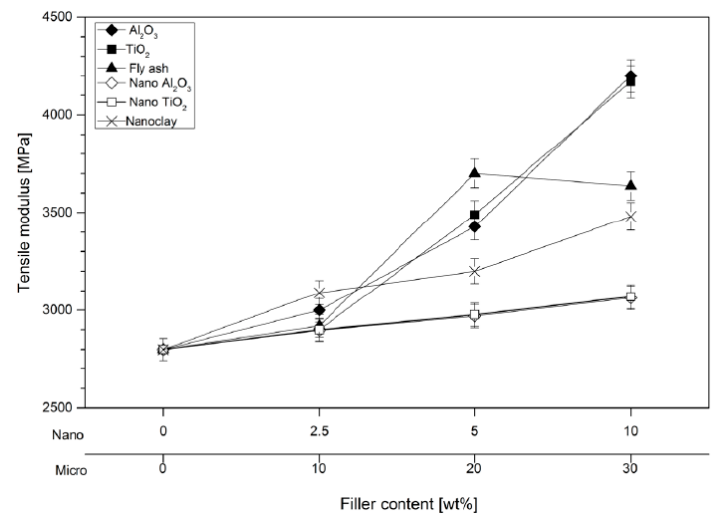
Figure 43. Tensile modulus of epoxy resin based micro/nanocomposites versus filler (Reprint with the permission of Strojniski vestnik–Journal of Mechanical Engineering [191]).